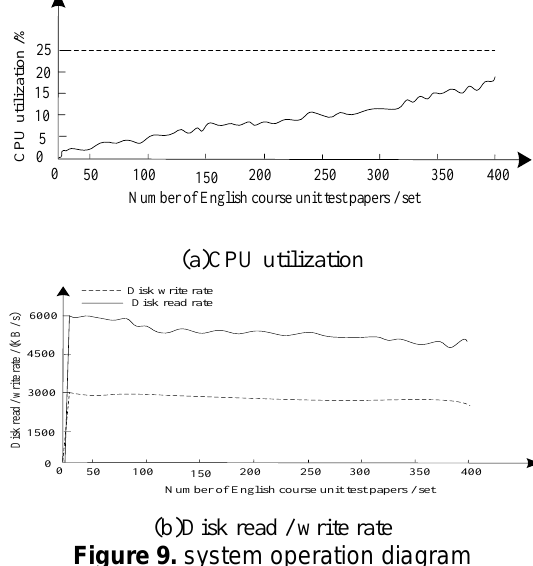
Figure 9. system operation